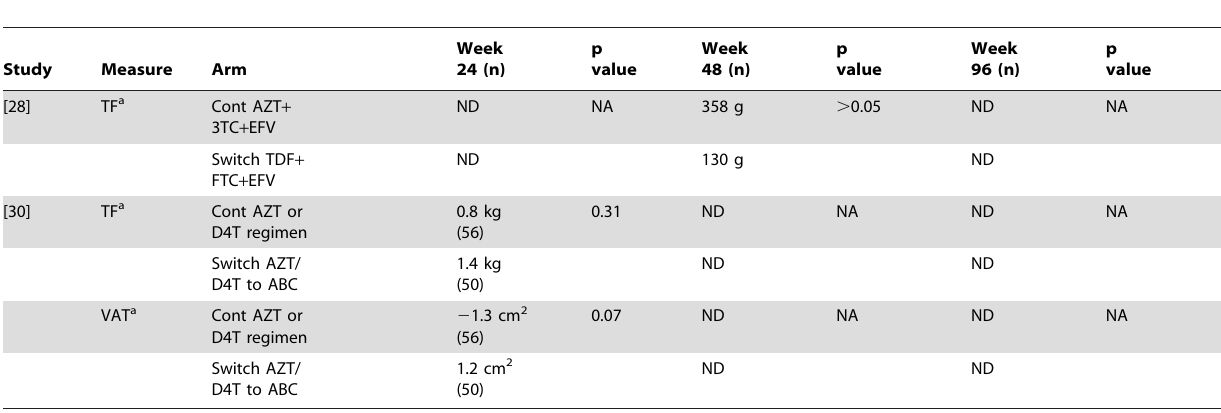
Table 24. Switching studies: change from baseline in trunk fat (TF) on DEXA scan and visceral adipose tissue (VAT) on CT scan: NRTI versus NRTI.